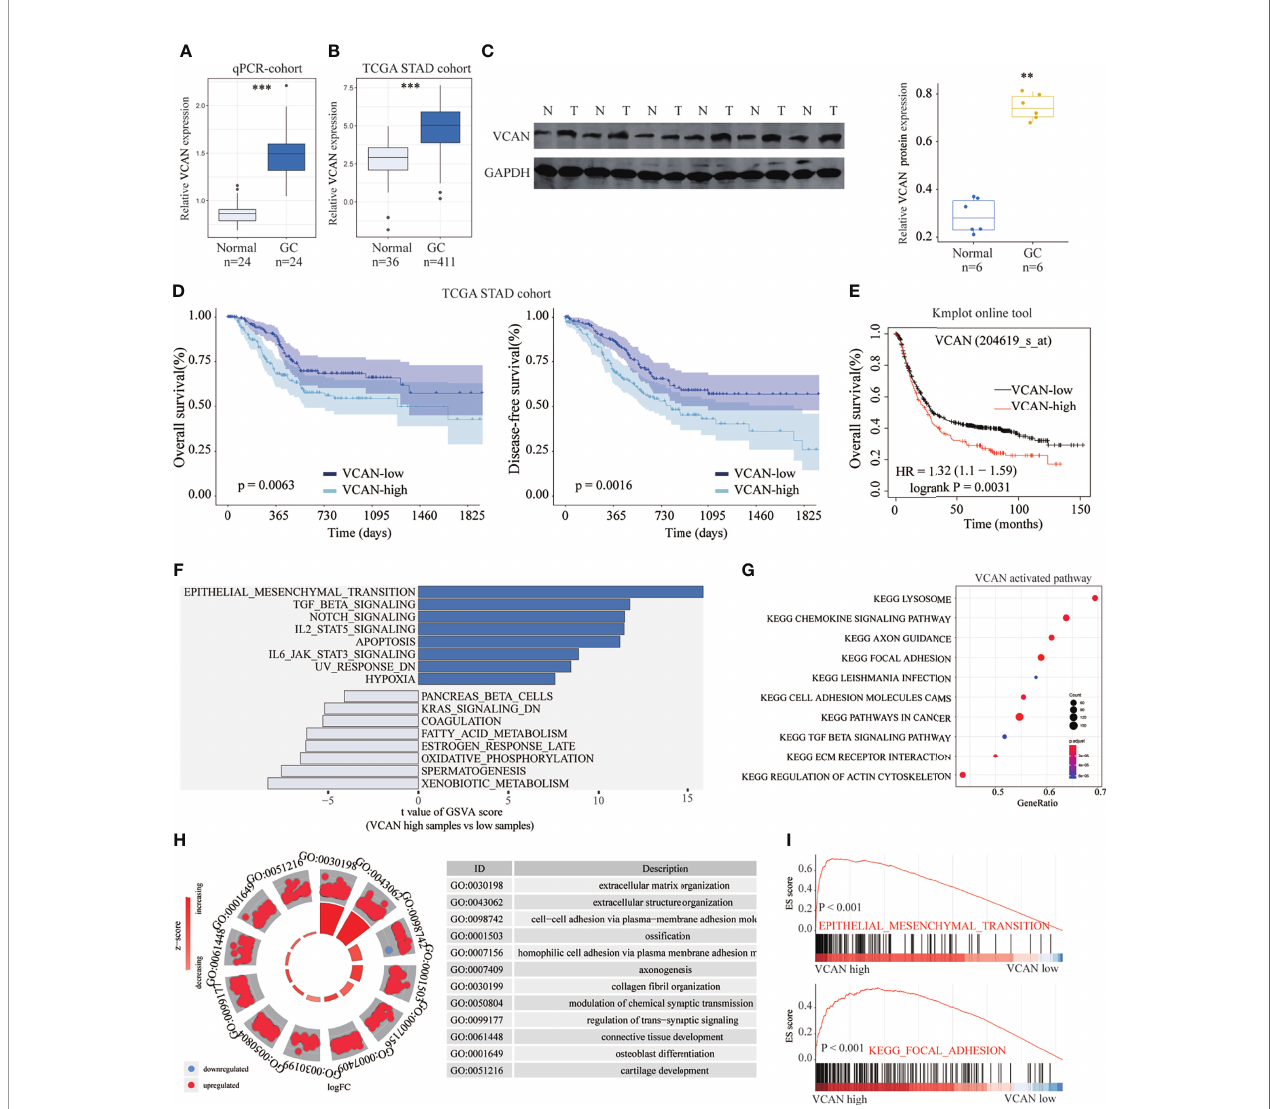
FIGURE 7 | The expression of VCAN in GC and its clinical signi fi cance. (A, B) VCAN expression was distinctly increased in GC specimens from our cohort and TCGA STAD cohort. (C) Western blot assays con fi rmed the increased levels of VCAN in GC specimens compared with non-tumor gastric specimens. (D, E) Survival assays based on VCAN expression using TCGA STAD cohort and kmplot online tool. (F) The bar plot showed the results of GSVA in the TCGA-STAD. (G) KEGG pathways signi fi cantly enriched. (H) The signi fi cantly enriched GO terms. (I) EMT and focal adhesion Signaling was enriched in the high-VCAN group. ** p < 0.01, *** p <